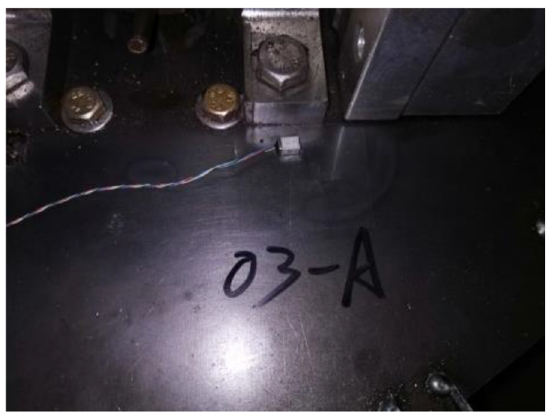
Fig. 10. Experimental acceleration data